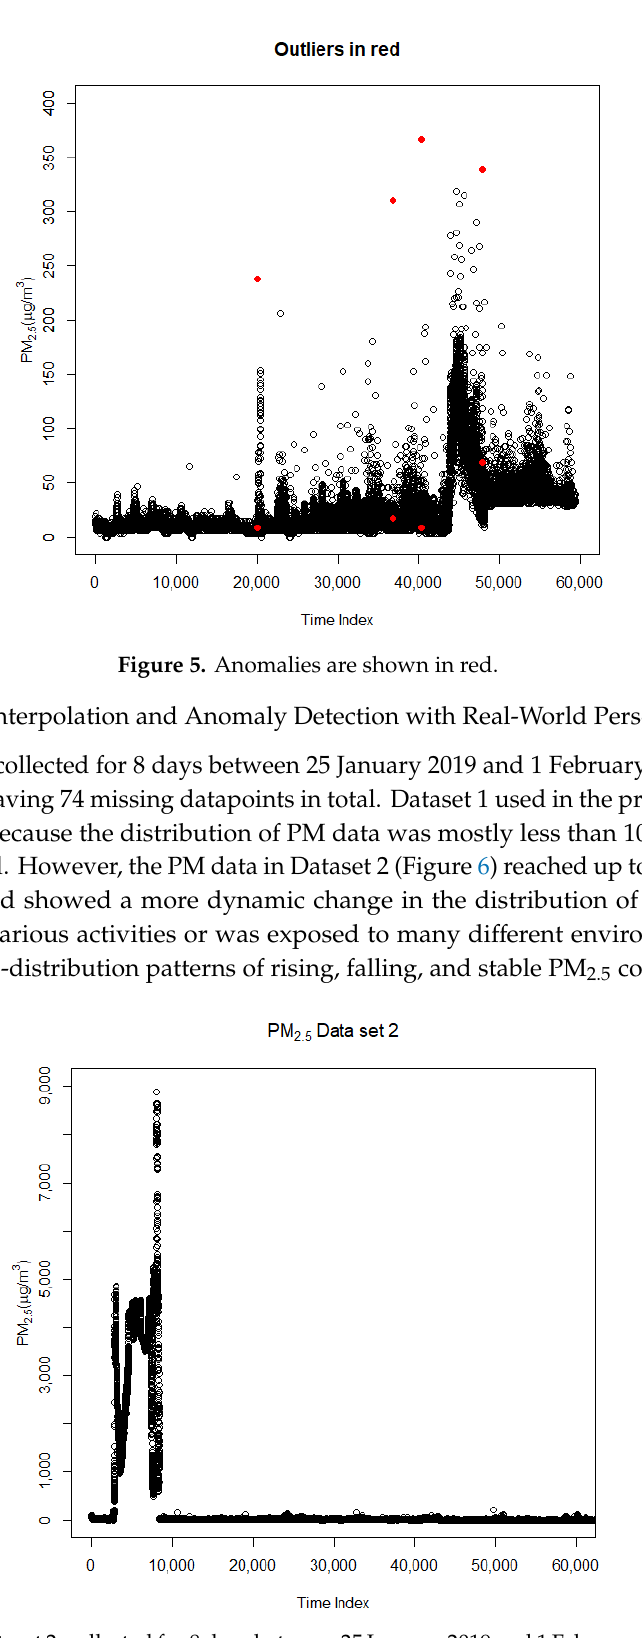
Figure 7. Optimal bandwidth for this dataset is chosen as being 19.